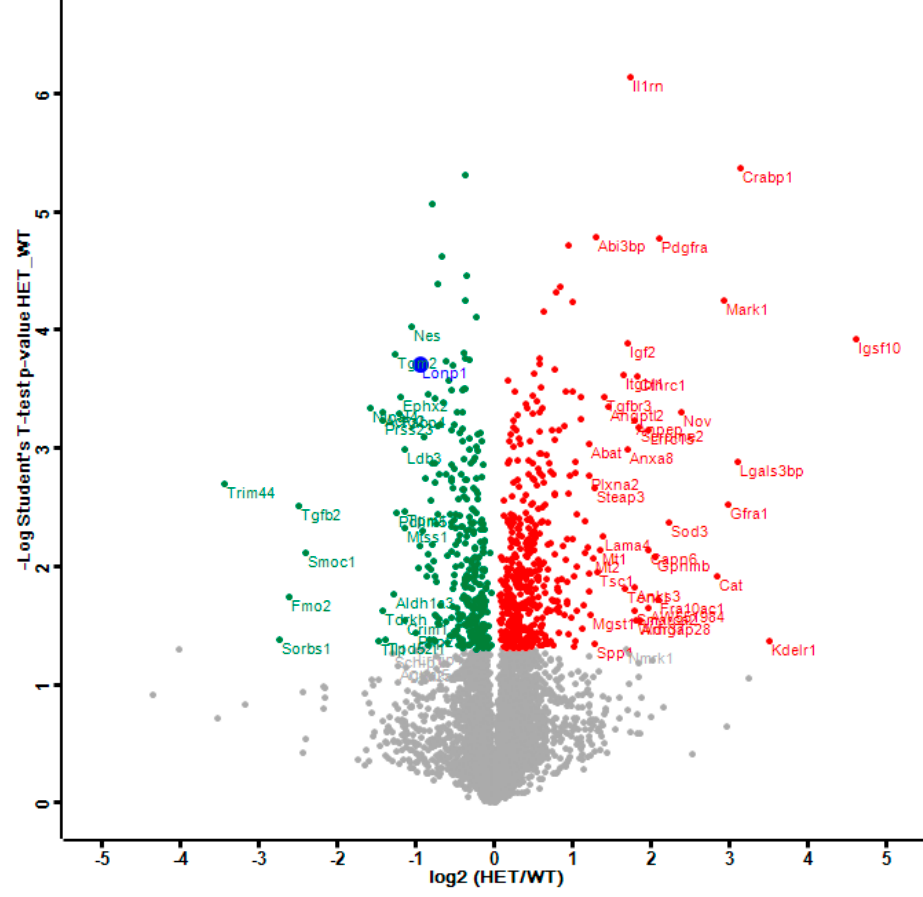
Figure 1. This Volcano plot represents all significant dysregulations in the global proteome of LonP1 +/ − mouse embryonal fibroblasts (MEFs) (heterozygous mutant (HET)) in green color (downregulated), red color (upregulated) or blue color (genetically deleted). The two-fold deficiency of LonP1 is represented by log2 ratio as –1 on the X-axis. Significance values are shown on the Y-axis. Peptides with non-significant changes are shown as grey dots. Factors of high significance despite moderate fold-change such as LonP1 can be easily distinguished in this diagram from other factors of massive fold-changes with higher variability such as the longevity and health span factor Fmo2 [59].